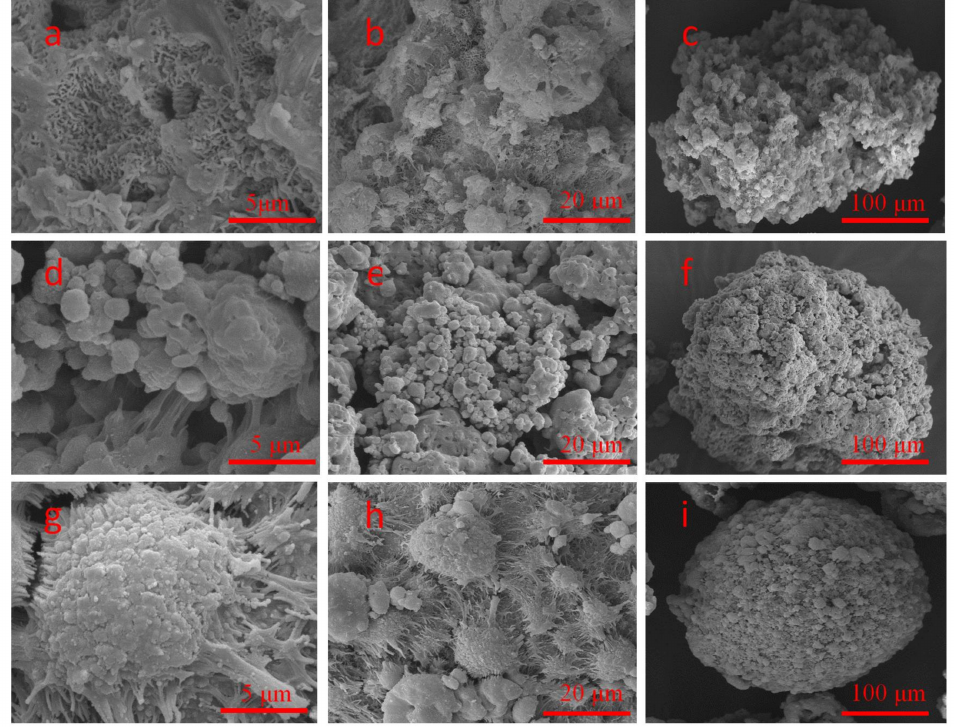
Figure 6. Scanning electron micrographs of PE copolymers particles. ( a – c ) PE-1 from POP-1-supported metallocene catalyst; ( d – f ) PE-2 from POP-2-supported metallocene catalyst; ( g – i ) PE-4 from 2408 silica-supported metallocene